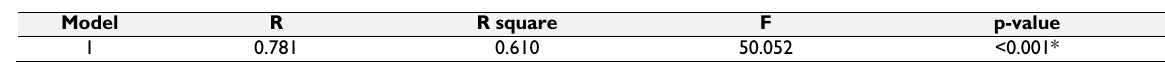
Table 5 Model summary